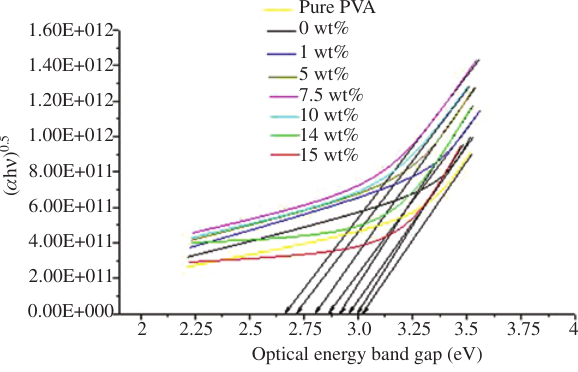
Figure 5: Optical energy band gap PVA/( x )MWCNTs(15- x )ZnO for various doping concentration.